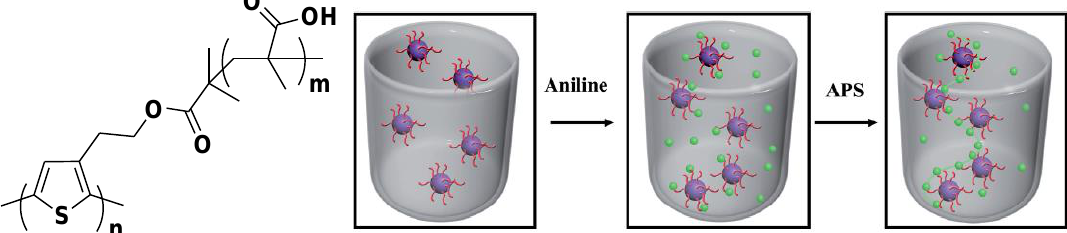
Figure 9. Chemical structure of grafted polythiophene dopant ( left ) and schematic illustration of hybrid helical structure formation. Violet spheres stand for polythiophene core, red hairs correspond to polymethacrylic acid chain, green spheres stand for aniline molecule and green chain with green spheres represents polyaniline. Reproduced with permission [80].